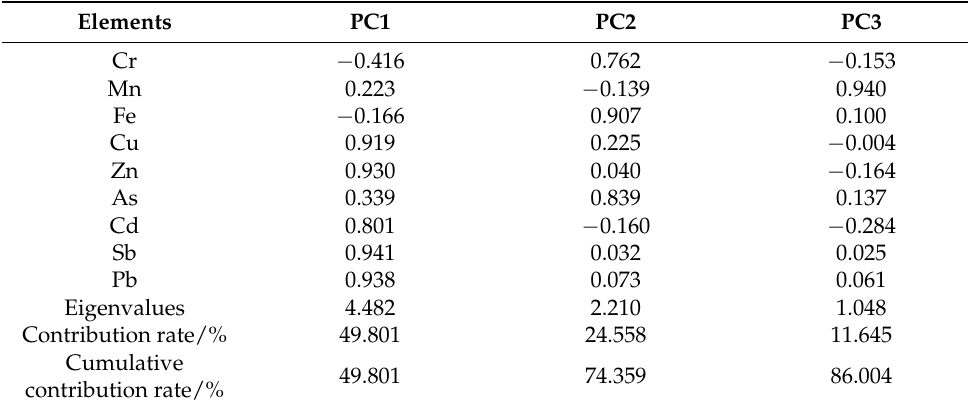
Table 3. Principal component analysis results of heavy metals ( n =